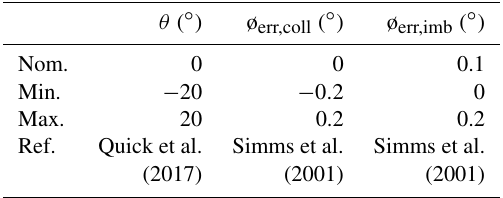
Table 10. Parameter value ranges of turbine controller